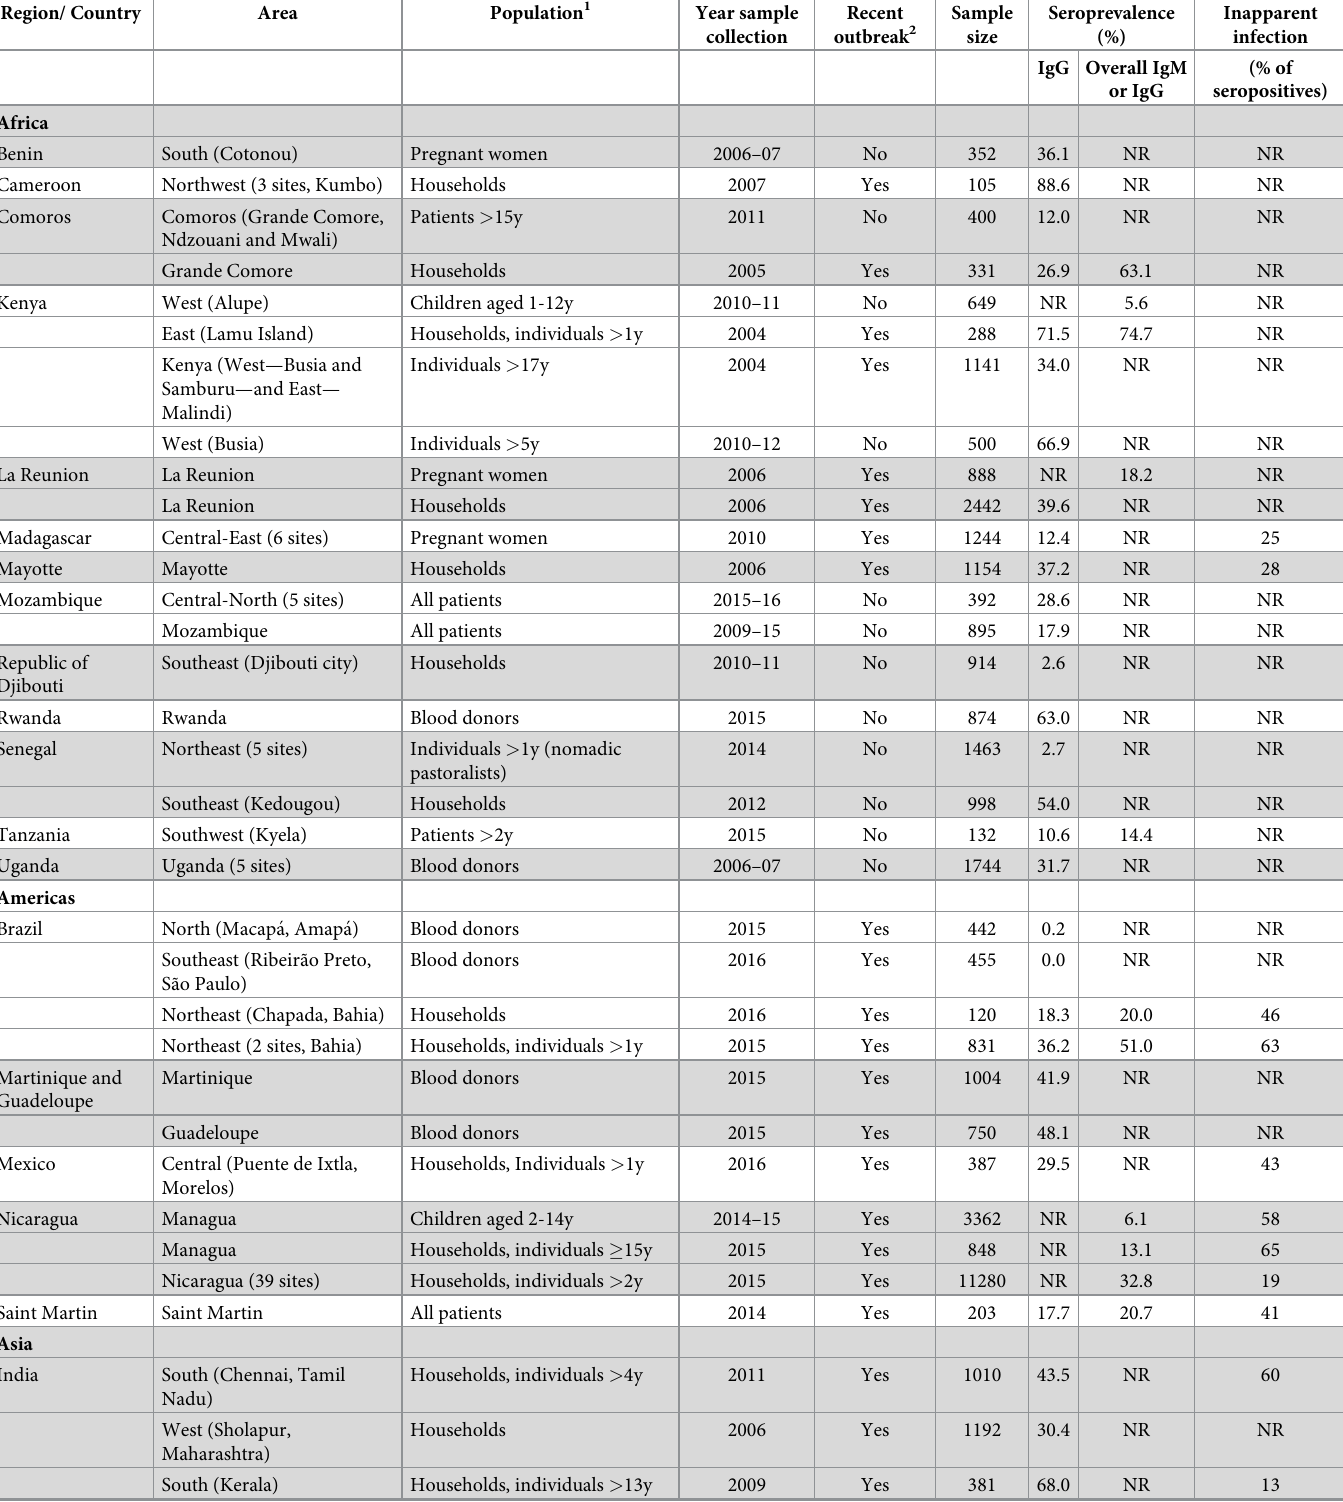
Table 2. Seroprevalence data by region and country, 1999–2020. Region/